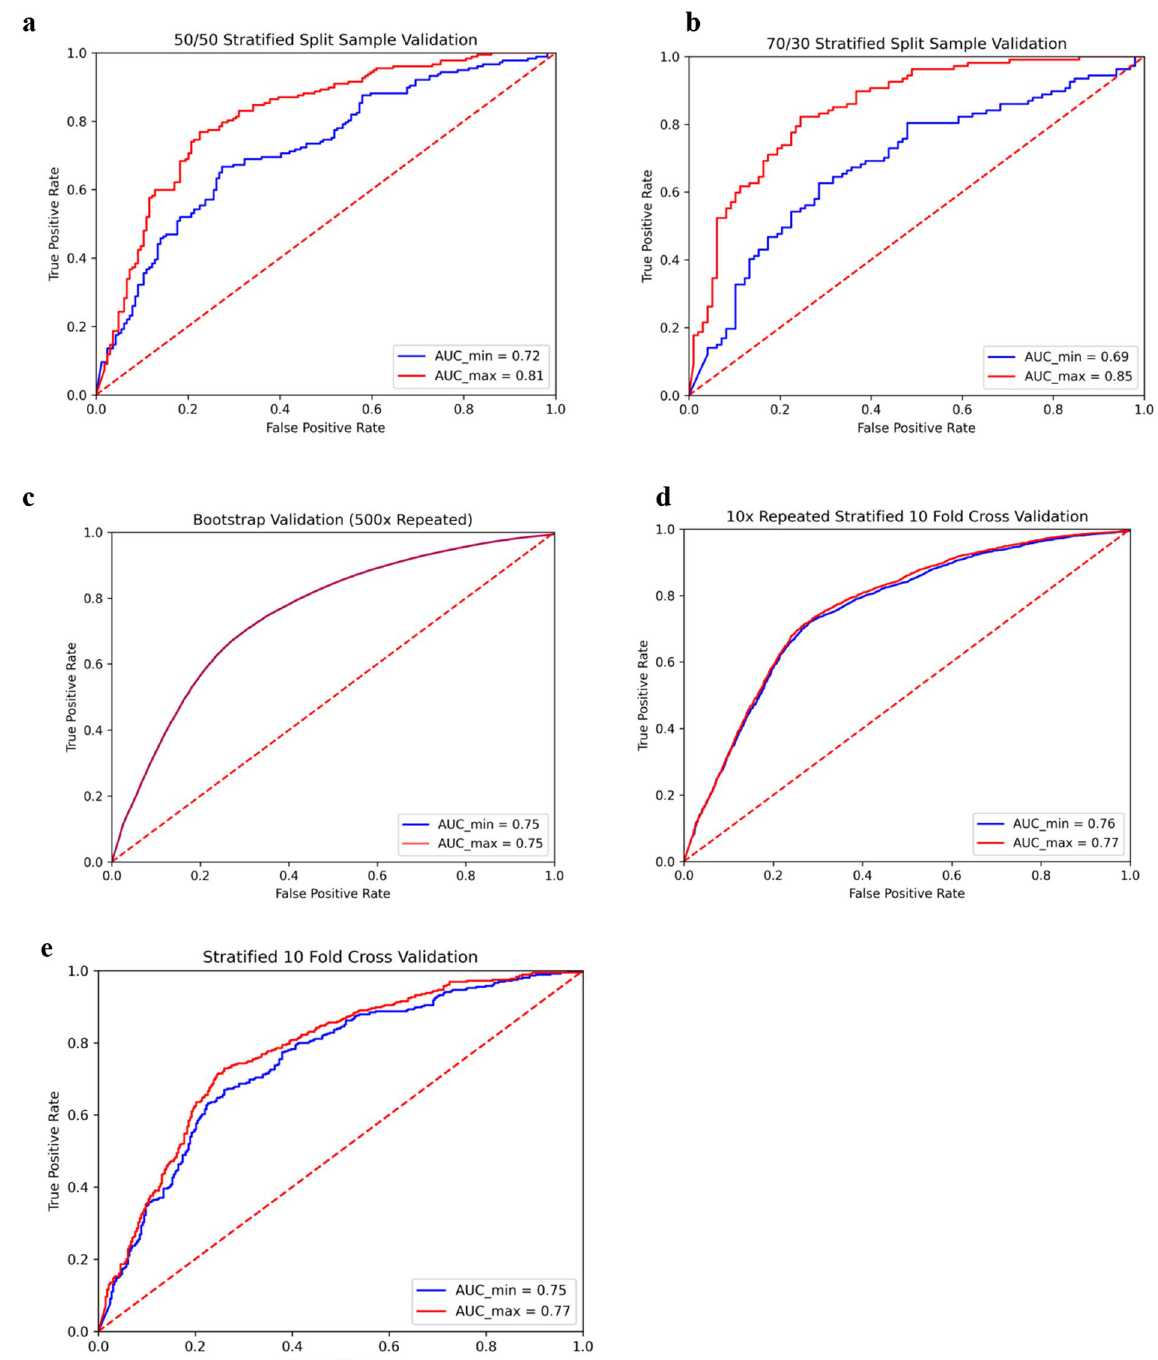
Figure 2. For experiments run using the Gaussian Naïve Bayes algorithm, two ROCs were generated for each validation technique (for the max and min AUCs) in order to visually observe the impact that seed changes could have on the ROC curve itself. (a) 50/50 Stratified Split Sample Validation. (b) 70/30 Stratified Split Sample Validation. ROC receiver operating characteristic curve. (c) Bootstrap Validation (500 × Repeated) 10-Fold Stratified CV. (d) 10 × Repeated 10-Fold Stratified CV. (e) 10-Fold Stratified CV. ROC receiver operating characteristic curve. AUC area under the ROC curve. ROC receiver operating characteristic